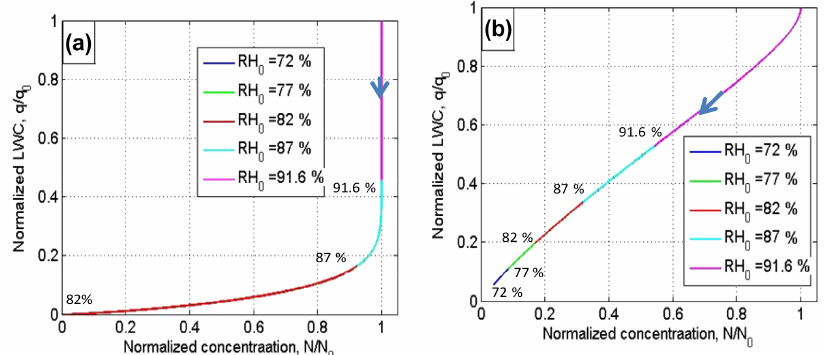
Figure 13. Dependencies of normalized LWC on the normalized number concentration of droplets calculated at different values of the initial relative humidity RH 0 in the resulting volume, for an initially narrow DSD (a) and an initially wide DSD (b) . The thermodynamic parameters are the same as in Fig. 7. The parameters of the initial DSDs are given in Table 3. Arrows denote the direction of increasing